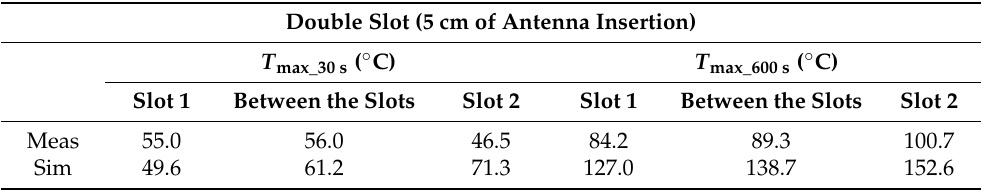
Table 2. Maximum temperatures reached by the antenna in the experiment and in the FEM model.